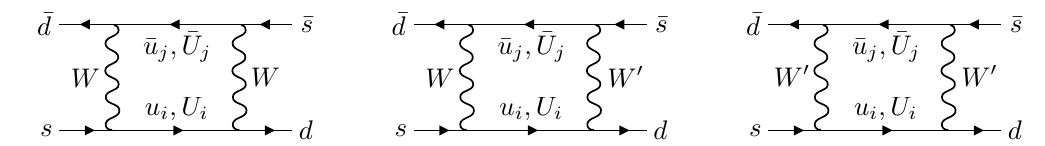
Figure 2 . Additional box diagrams contributing to kaon mixing in the models under consideration include any of the up-type quarks propagating inside the loop, as well as (left) two W bosons, (center) one W and one W 0 , and (right) two W 0 s. Quantitatively, it is diagrams with one W and one W 0 that are the most